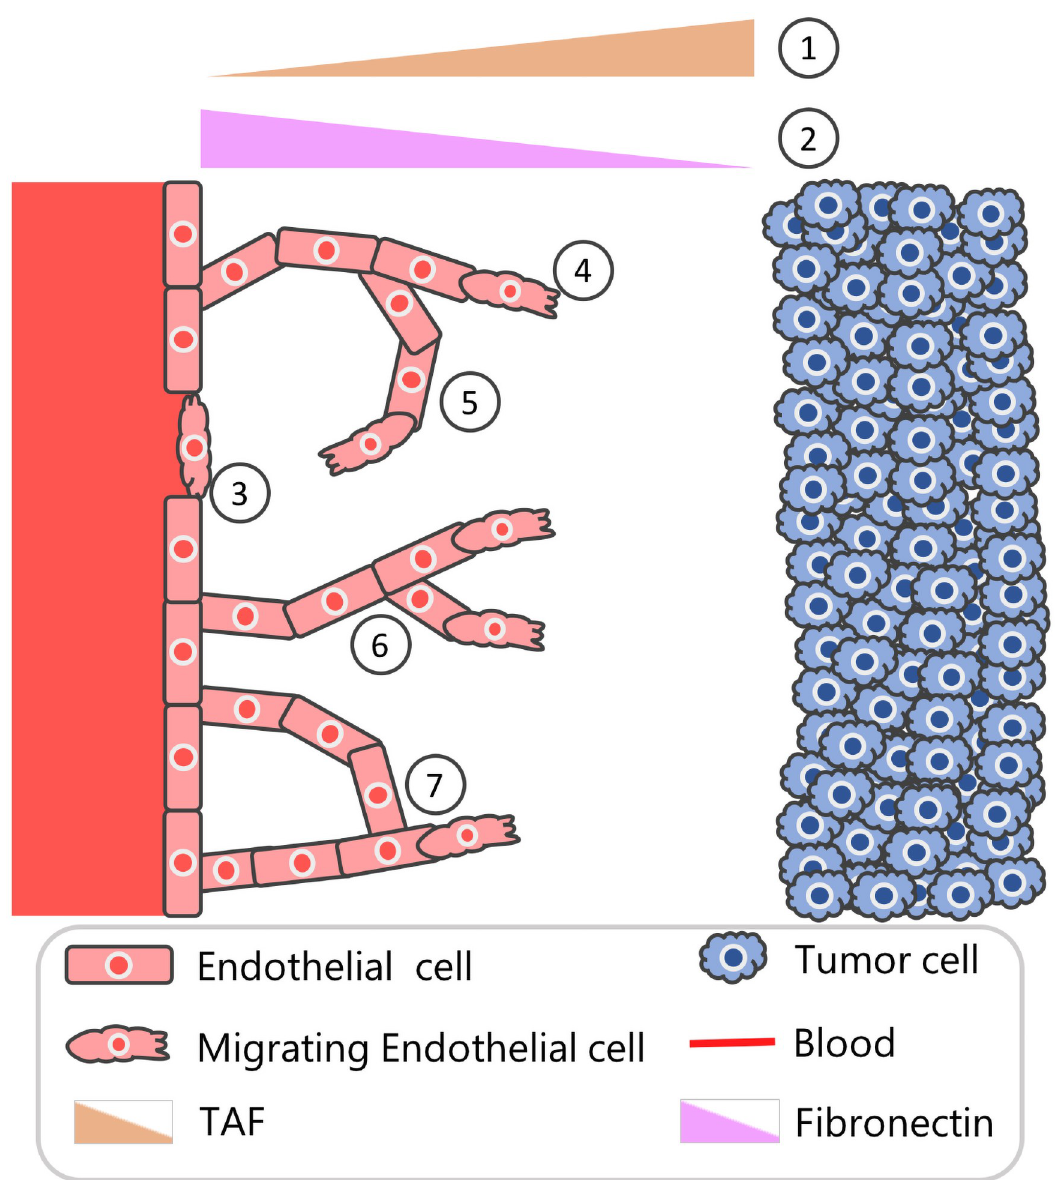
Fig 1. Schematic overview of tumor-induced angiogenesis. Schematic depicting seven aspects angiogenesis that are incorporated in the Anderson-Chaplain model of tumor-induced angiogenesis [17]. (1) Distant tumor cells release a range of chemoattractants, including vascular endothelial growth factors and basic fibroblast growth factors that stimulate the formation of new blood vessels. These growth factors are described collectively as a single, generic tumor angiogenesis factor (TAF). (2) Production and consumption of tissue-matrix bound fibronectin by the endothelial cells creates a spatial gradient of fibronectin across the domain. (3) Endothelial cells sense the TAF and fibronectin gradients and undergo individual cell migration. (4) As endothelial tip cells migrate, via chemotaxis, up spatial gradients of the TAF, stalk cells in the developing vessels are assumed to proliferate, creating what has been termed a “snail trail” of new endothelial cells. (5) Endothelial tip cells also migrate, via haptotaxis, up spatial gradients of fibronectin. (6) Endothelial cells in existing sprouts may initiate the formation of secondary sprouts. (7) If a sprout coincides with an existing vessel, then it is assumed to be annihilated and a new loop is formed; if two sprouts coincide or anastomose, then both are assumed to be annihilated and a new loop